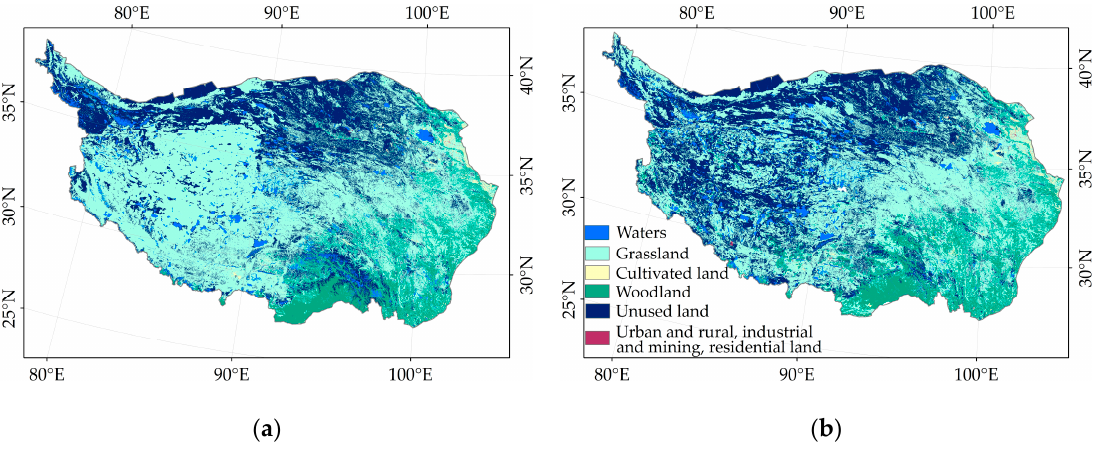
Figure 6. Land use and cover changes on the QTP: ( a ) 1980; ( b )